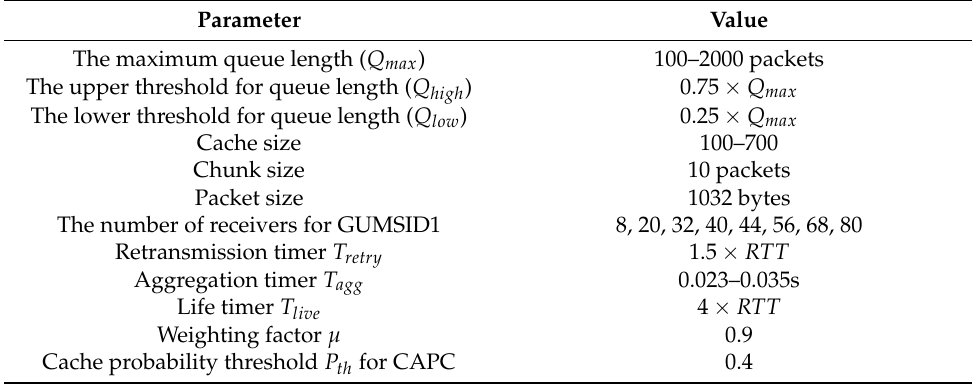
Table 3. Experiment parameters.